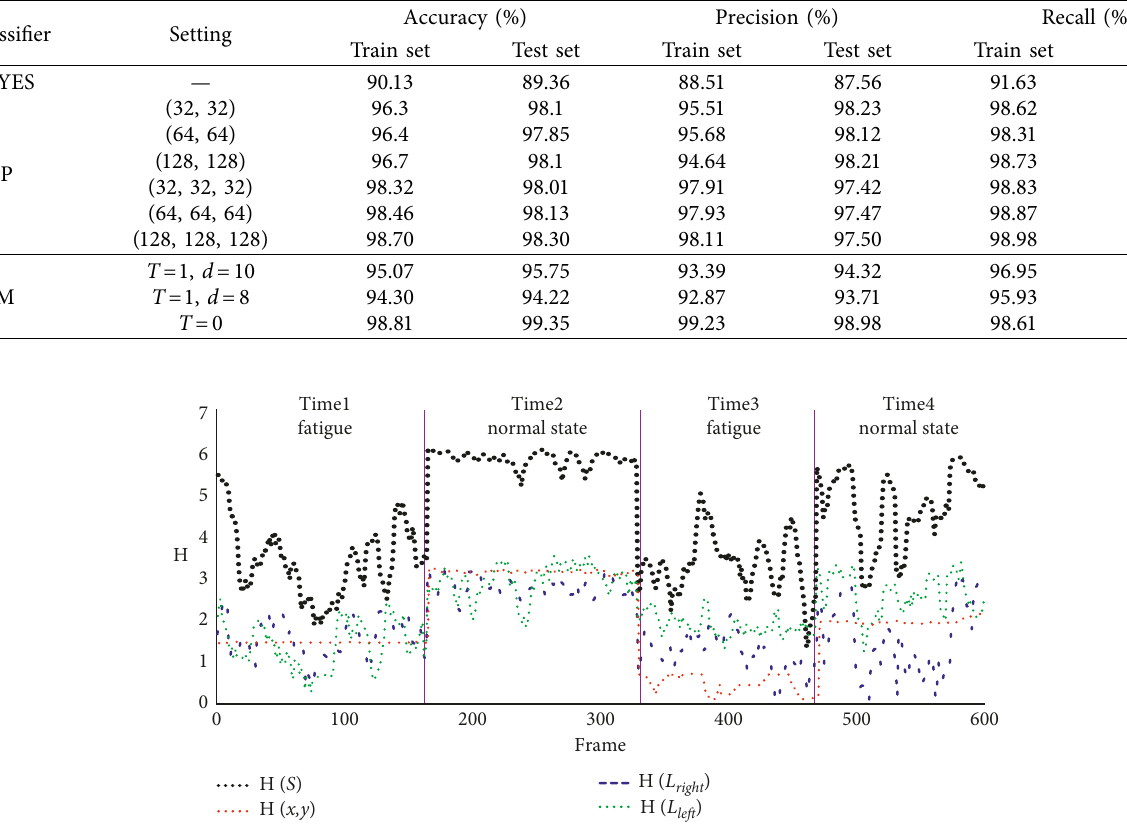
Figure 14: The change of the information entropy value of the test set in different states.